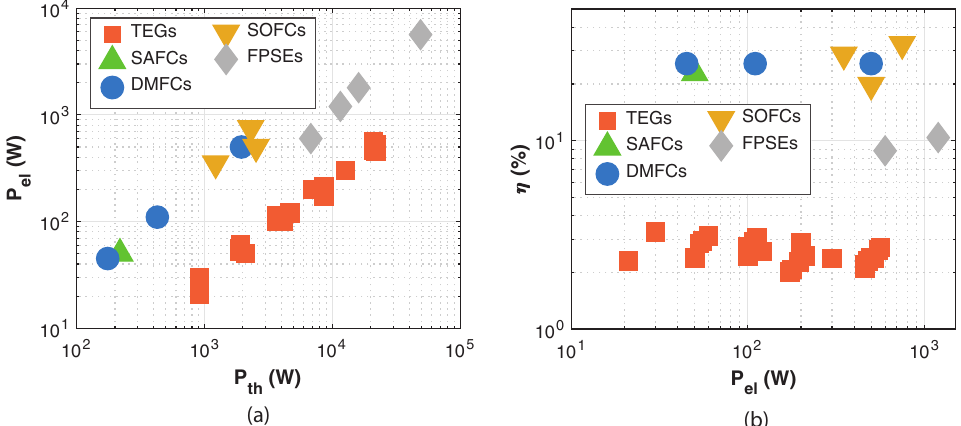
Figure 10. Comparison of power levels ( a ) and nominal efficiencies ( b ) of TEGs, FCs and